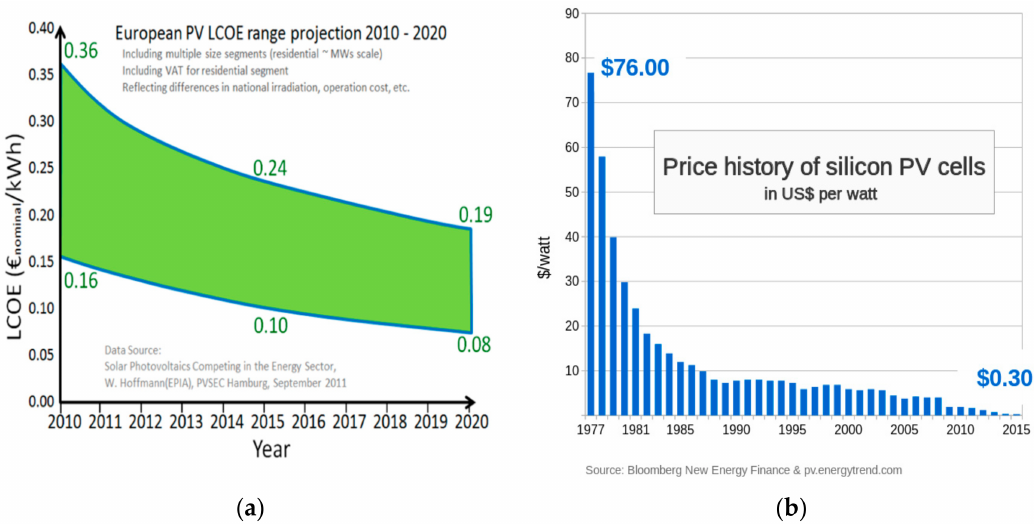
Figure 5. ( a ) LCOE range of photovoltaics (Europe); and ( b ) price history of silicon photovoltaics (Wikipedia.com).